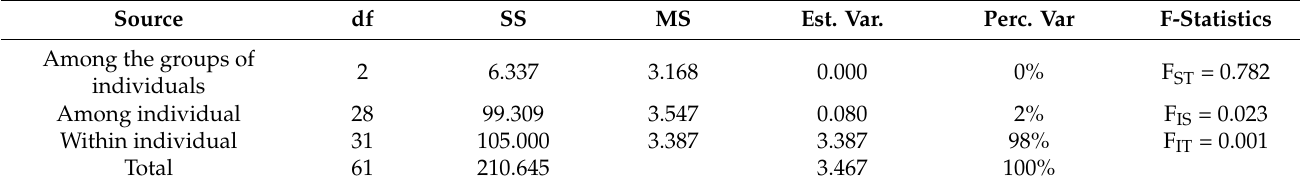
Table 6. AMOVA among and within groups of sweetpotato